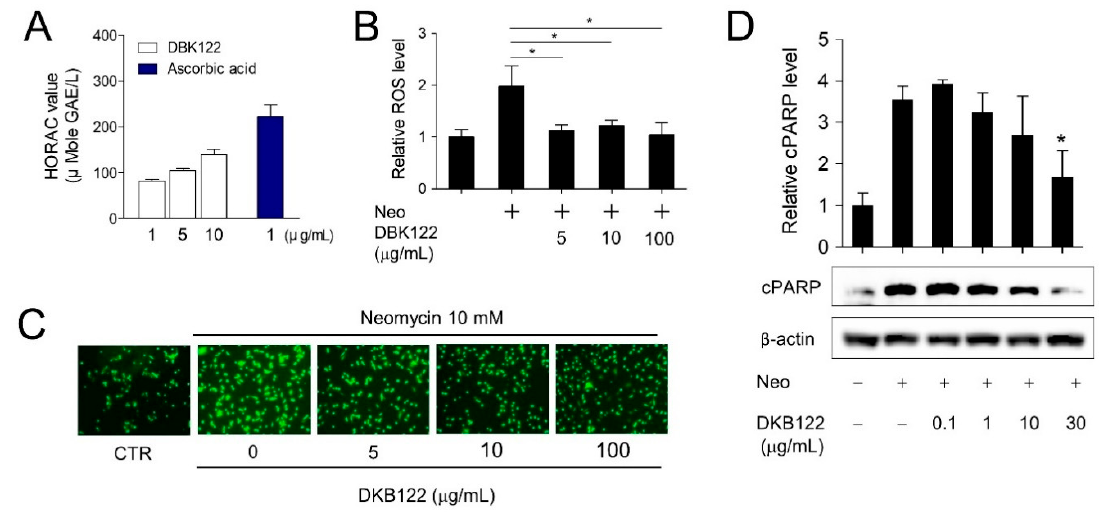
Figure 3. DKB122 attenuates intracellular ROS induced by neomycin and prevents apoptotic activation in HEI-OC1 cells. ( A ) HORAC assay, measuring the antioxidant activity of DKB122 (1–10 µ g / mL). L-ascorbic acid (1 µ g / mL) was used as the control. ( B ) HEI-OC1 cells were pretreated with DKB122 (5–100 µ g / mL) for 1 h, then neomycin (10 mM) for an additional 24 h. Cells were stained with DCFH-DA (30 µ M) for 30 min. ROS intensities were determined by measuring fluorescence. ROS intensities were normalized to cell viability. The results are presented as mean ± SD ( n = 3, * p < 0.05). ( C ) ROS signal image obtained using fluorescence microscopy. ( D ) HEI-OC1 cells were incubated with DKB122 (0.1–30 µ g / mL) 1 h prior to neomycin treatment (10 mM, 24 h). Cleaved PARP (cPARP) protein was detected using western blotting. β -actin was used as a loading control. The relative amount of cleaved PARP was evaluated using ImageJ. The results are presented as mean ± SD of four independent experiments ( n = 4, * p < 0.05).